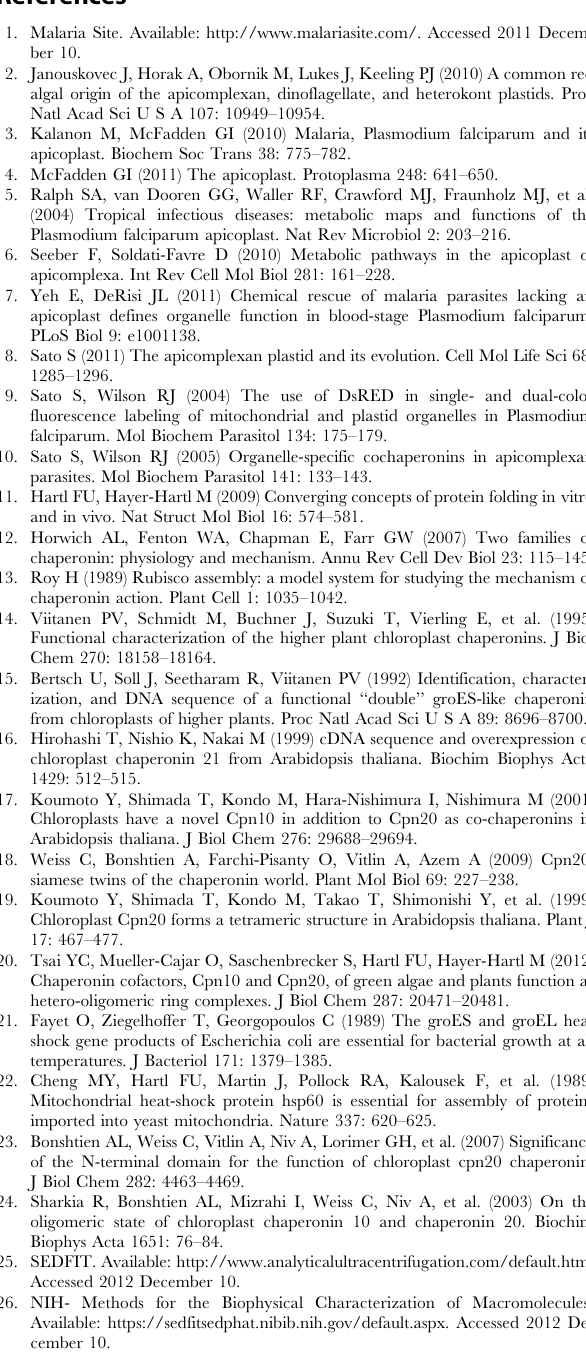
Table S1 Primers used for cloning of constructs for in vivo